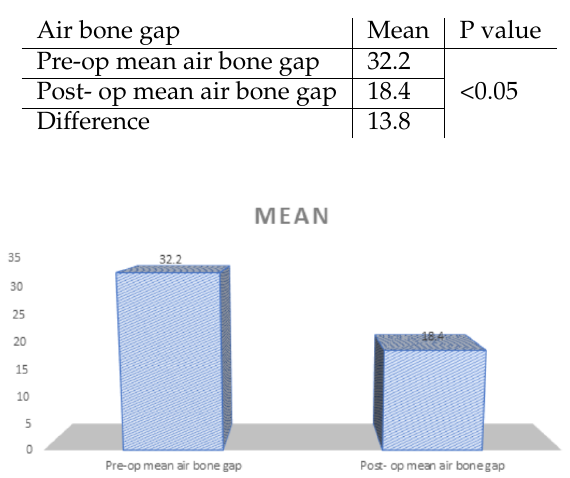
Figure 3. Graphical distribution of measurement of air bone